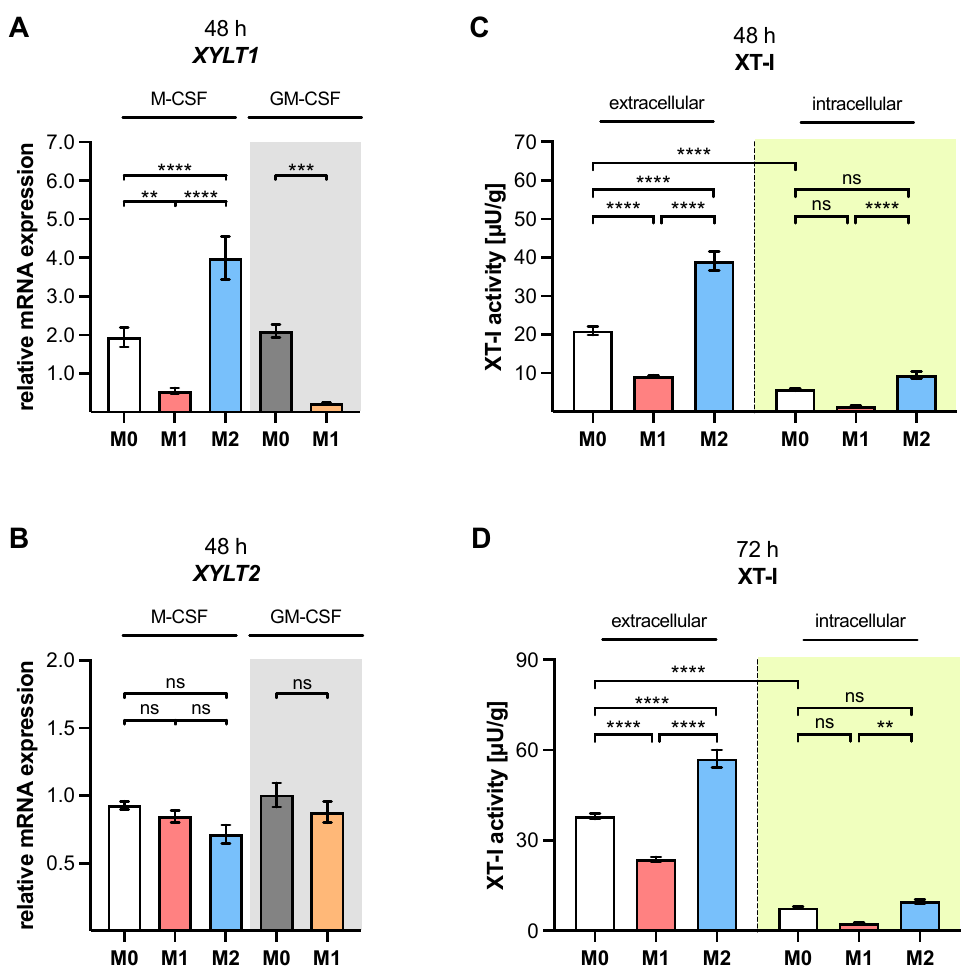
Figure 1. Expressions of XYLT1 and XYLT2 , and cellular XT-I activity of polarized macrophages. Negatively selected monocytes were differentiated to macrophages using M-CSF or GM-CSF (highlighted in grey). After 6 days, M Φ were stimulated with IFN- γ /LPS (M1), IL-4 (M2), or with no additive (M0). Cells were harvested after a polarization time of 48 h. The relative gene expressions of ( A ) XYLT1 and ( B ) XYLT2 were determined via qRT-PCR analysis (n, sample = 3; n, biological = 2; n, technical = 3). Polarization times of ( C ) 48 h and ( D ) 72 h were applied for cellular XT-I activity determination of polarized M-M Φ (n, sample = 3; n, biological = 3; n, technical = 3) by mass spectrometry. The cell culture supernatant was collected for the extracellular XT-I activity determination, while the cell lysate was used for intracellular XT-I activity (highlighted in yellow) measurement. XT-I activities were referred to the total protein content of the lysates, and are expressed in μ U/g. All data were analyzed using one-way ANOVA, followed by Tukey’s multiple comparison tests, and expressed as mean ± SEM. ns (not significant), p < 0.01 (**), p < 0.001 (***), p < 0.0001 (****).